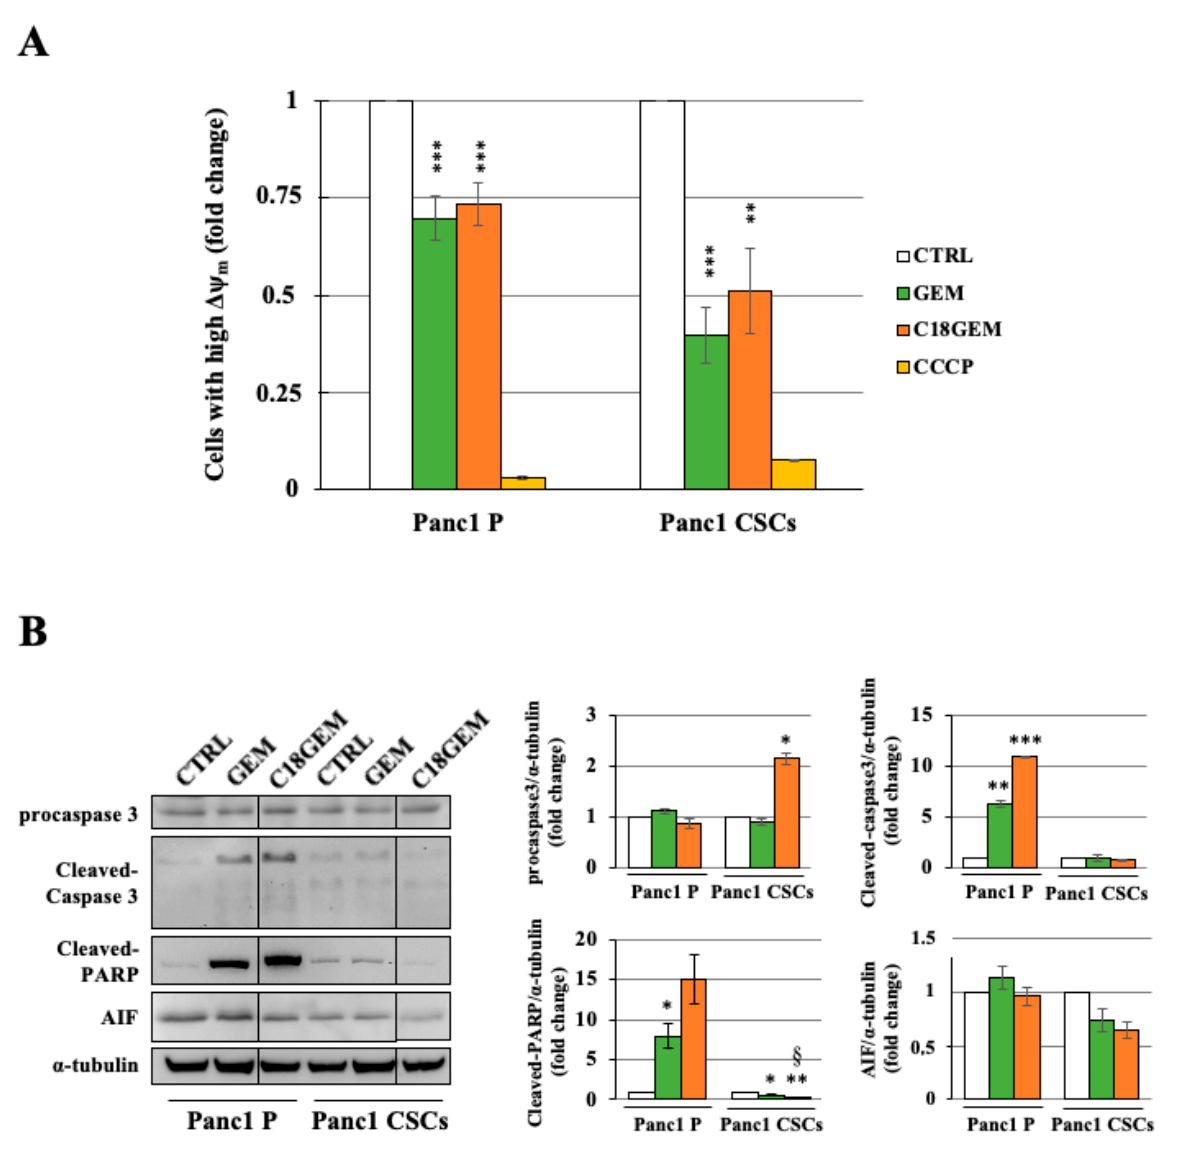
Figure 4. Molecular mechanism of regulated cell death in Panc1 parental cells and Panc1 CSCs. Analysis of mitochondrial membrane potential with JC-1 of Panc1 P cells and CSCs treated with 50 μ M of GEM, or C18GEM for 48 h, and the uncoupling compound (CCCP) used as a positive control ( A ). Representative Western blot and quantification of procaspase 3, cleaved caspase 3, cleaved- poly-ADP-ribose polymerase 1 (PARP), and apoptosis-inducing factor (AIF) expression of Panc1 parental (P) cells and CSCs treated with 50 μ M of GEM or C18GEM for 48 h in 2D conditions ( B ). The values are reported as fold change relative to untreated cells and are the means (± SE) of at least three independent biological replicates. Statistical legend: p < 0.05 (*) or p < 0.01 (**) or p < 0.001 (***) GEM or C18GEM versus CTRL; p < 0.05 (§) C18GEM versus GEM.